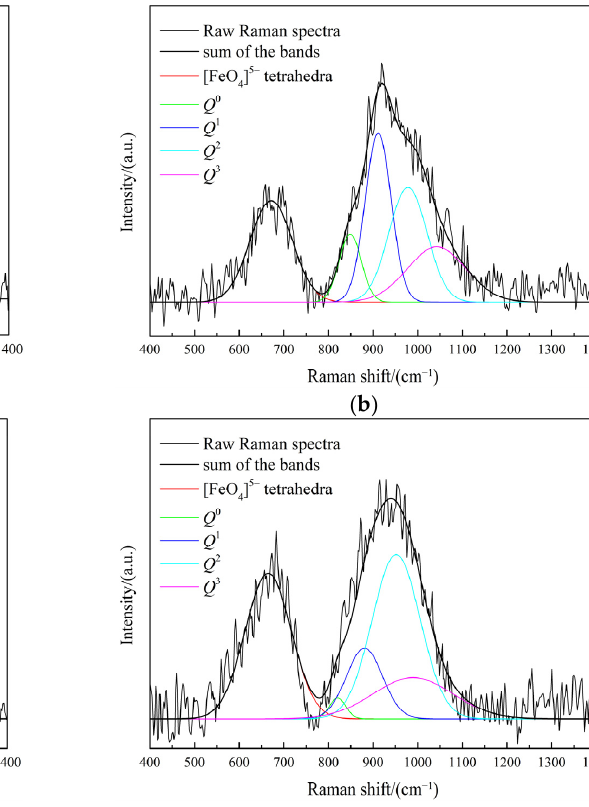
Figure 12. FTIR results with various Fe 2 O 3 content in the FeO − X wt%Fe 2 O 3 − SiO 2 − 8 wt%CaO − 3 wt%MgO − 3 wt%Al 2 O 3 melts at Fe/SiO 2 of ( a ) 0.8 and ( b ) 1.2.